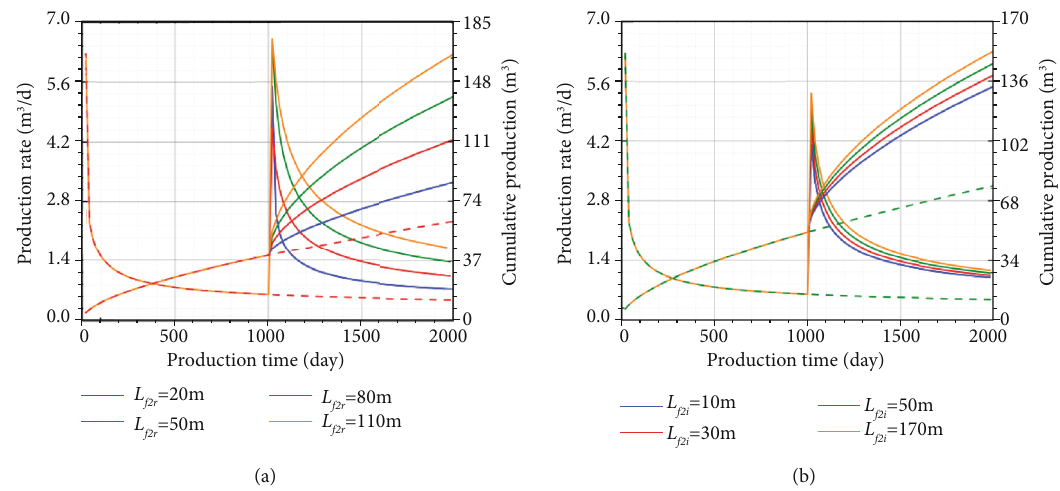
Figure 7: Performance of the refractured well with (a) di ff erent lengths of reoriented section and (b) di ff erent lengths of initially reoriented